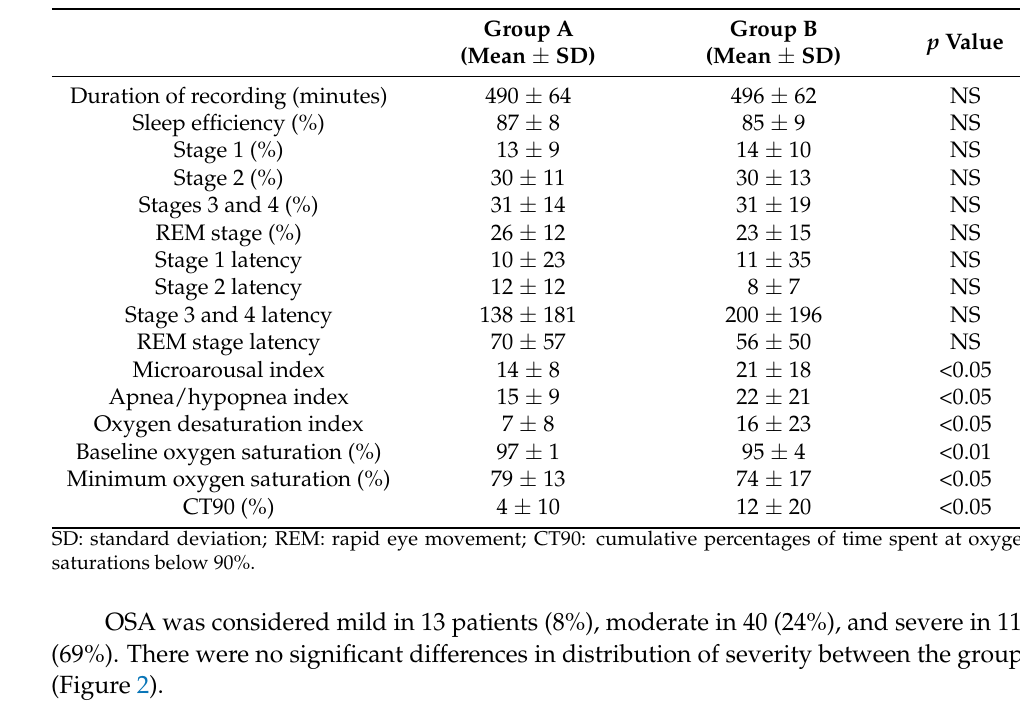
Table 2. Comparison of polysomnography variables in Groups A and B.